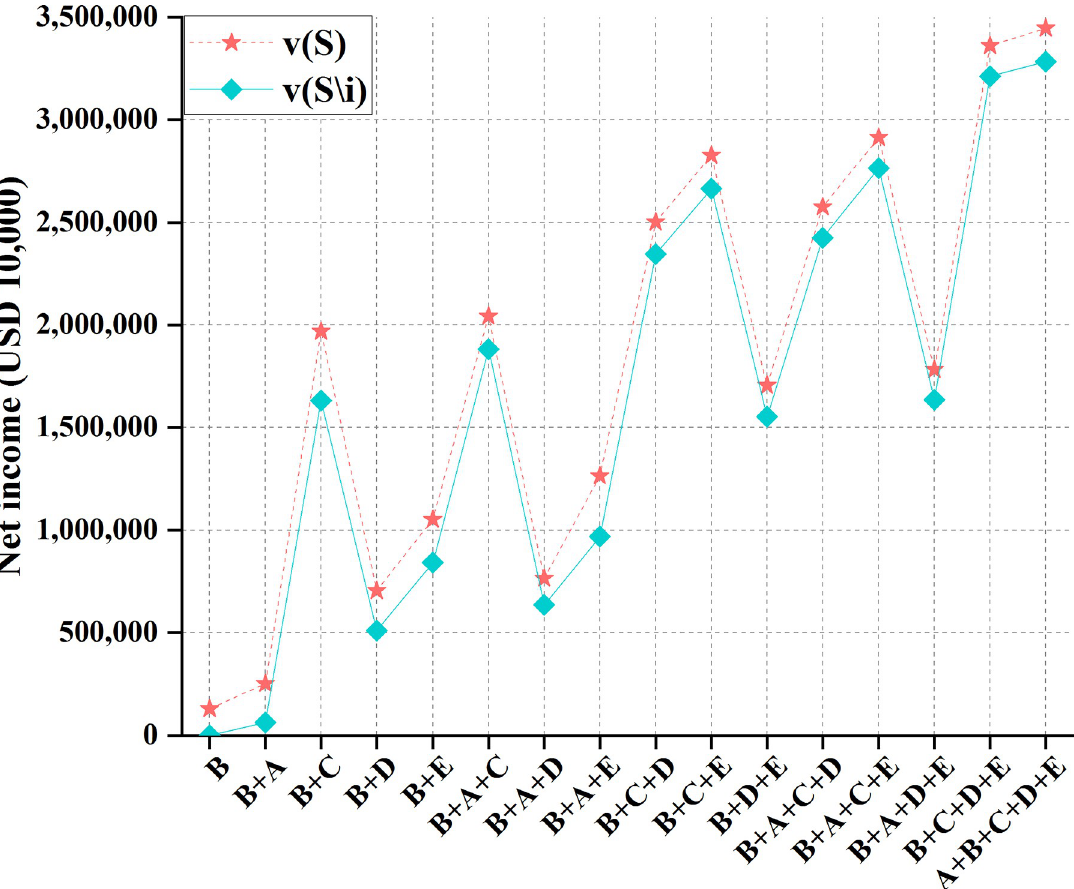
Fig 13. Comparison of profits of 16 cooperation modes between Laos and other four countries.